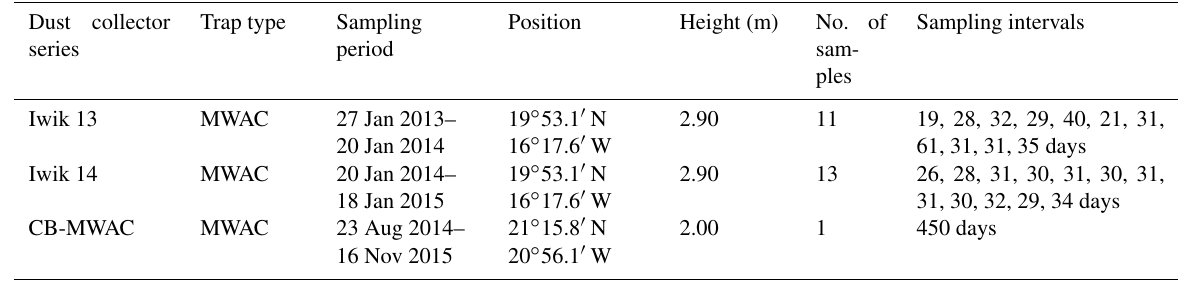
Table 4. Specifications of the MWAC samples collected during 2013–2015 chosen for flux and grain-size